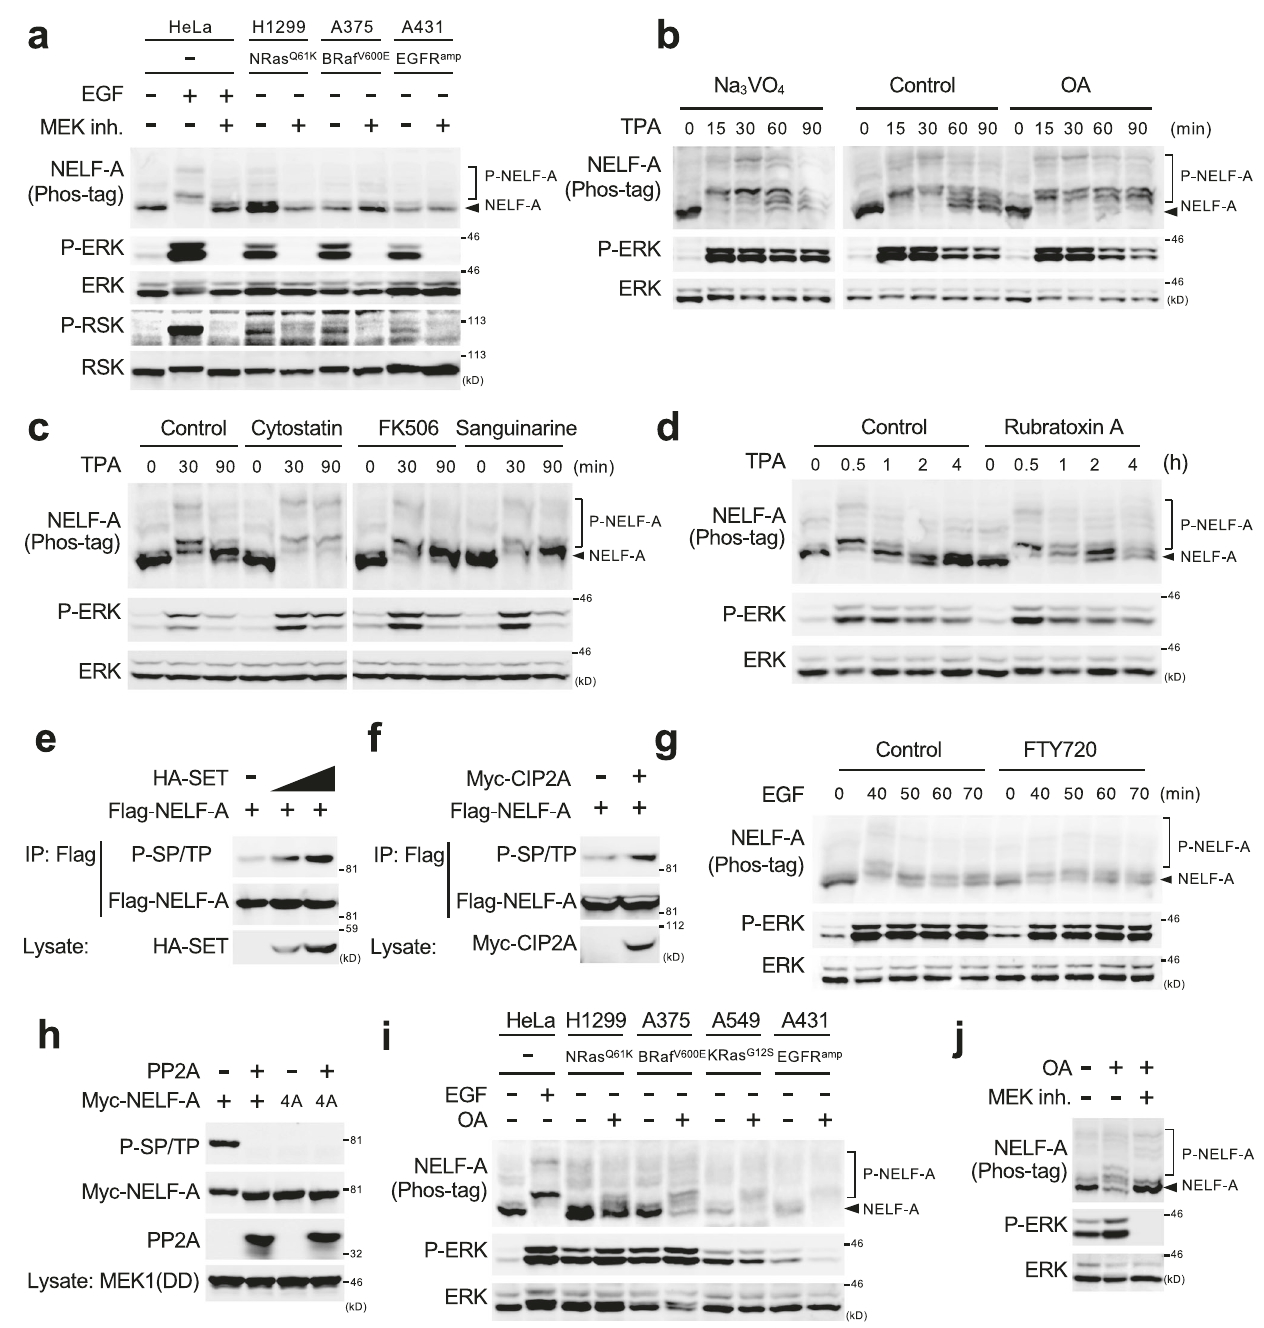
Fig.6|PP2Acounteractsoncogene-inducedNELF-Aphosphorylationincancer cells. a Cells were treated with or without the MEK inhibitor, trametinib. The phosphorylation status of endogenous NELF-A was analyzed using Phos-tag SDS- PAGEfollowedbyimmunoblottingwithananti-NELF-Aantibody.HeLacells+EGF served as a positive control. b – d HeLa cells were pretreated with an inhibitor of dual-speci fi city and tyrosine phosphatases (Na 3 VO 4 , 500 μ M), a PP2A inhibitor (OA, 400nM), or control solvent (DMSO) ( b ), with a selective PP2A inhibitor (Cytostatin, 20 μ M), a PP2B inhibitor (FK506, 0.2 μ M), or a PP2C inhibitor (Sanguinarine,0.5 μ M)( c ),orwithaspeci fi cPP2Ainhibitor(RubratoxinA,20 μ M) ( d ) for 60min, and stimulated with TPA (300nM) for the indicated times. The phosphorylationstatusofendogenousNELF-Awasmonitoredasin a . e , f HEK293 cells were transfected with Flag-NELF-A, together with HA-SET ( e ) or Myc-CIP2A ( f ).PhosphorylationofimmunoprecipitatedFlag-NELF-Awasprobedwithananti-